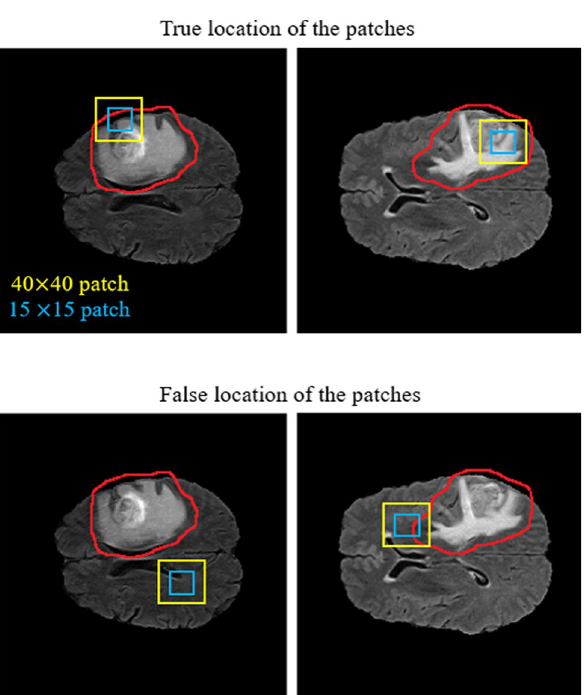
Figure 11. Our implemented cascade structure. The green and red windows inside the input images represent the local and global patches, respectively. The DWA module is represented at the end of the structure before the FC layer.